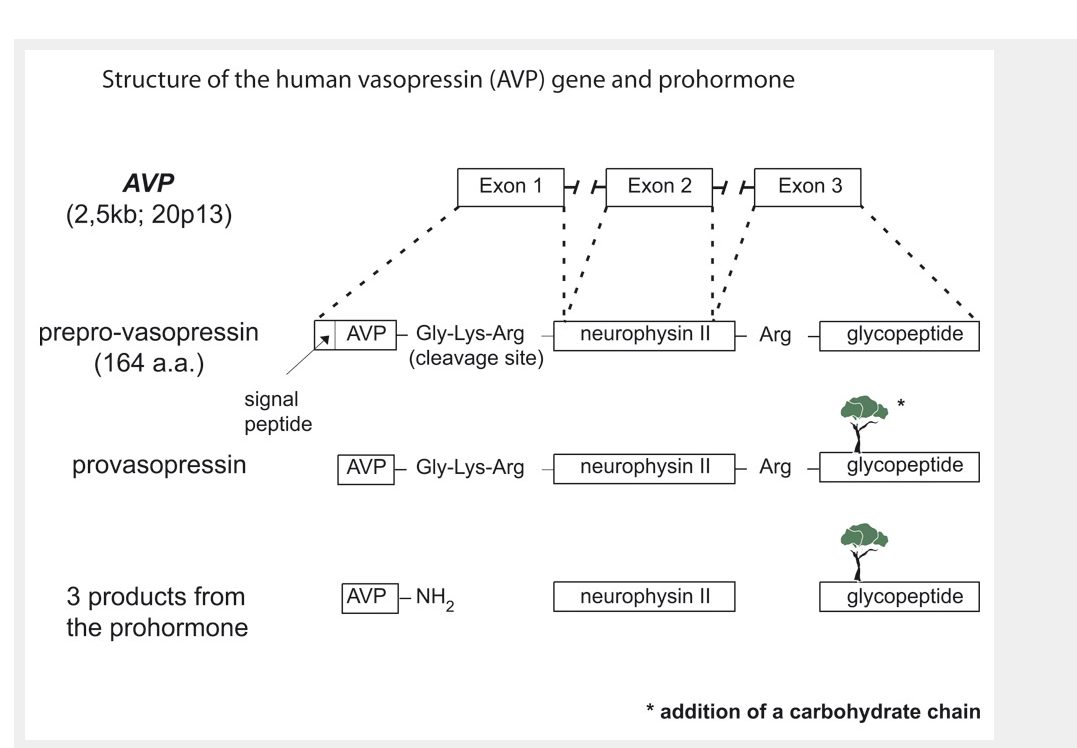
Figure 4 Structure of the human vasopressin (AVP) gene and cascade of vasopressin biosynthesis, signal peptide; AVP, arginine-vasopressin; neurophysin;